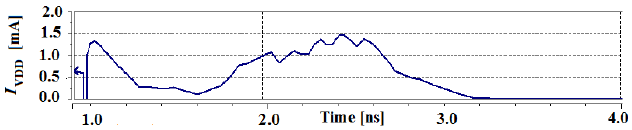
Figure 13. Supply current ( I DD ) for the situation shown in Figure 12.